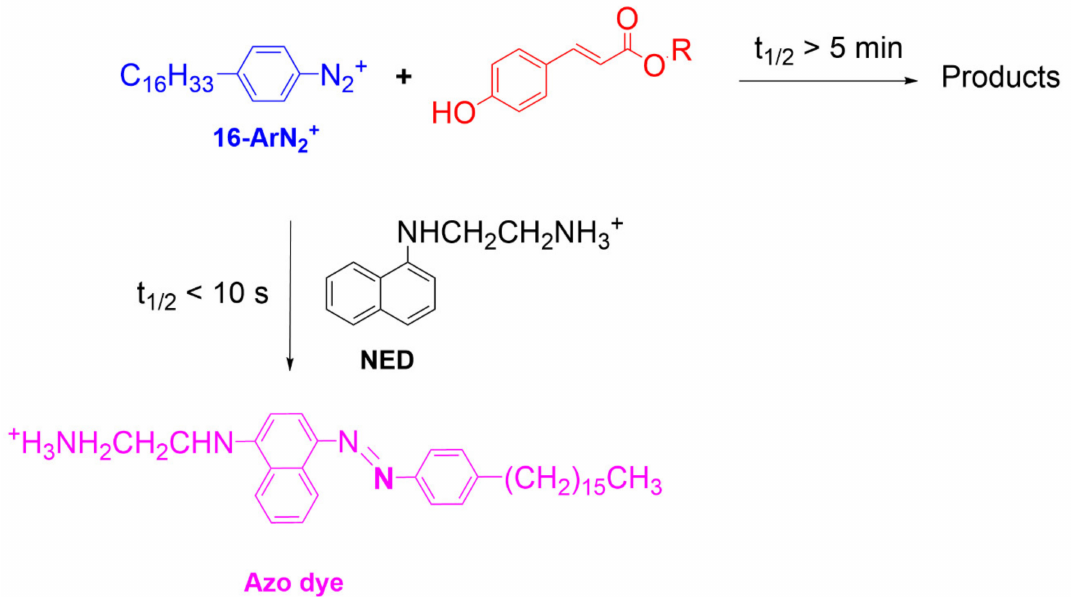
Scheme 5. Competitive reactions of 16-ArN 2+ with AOs and with the coupling reagent NED to yield a stable azo dye. Exper- imental conditions were optimized so that the reaction with NED was much faster than that with AOs, allowing monitoring of the disappearance of 16-ArN 2+ with time in emulsions. Details of the method can be found elsewhere